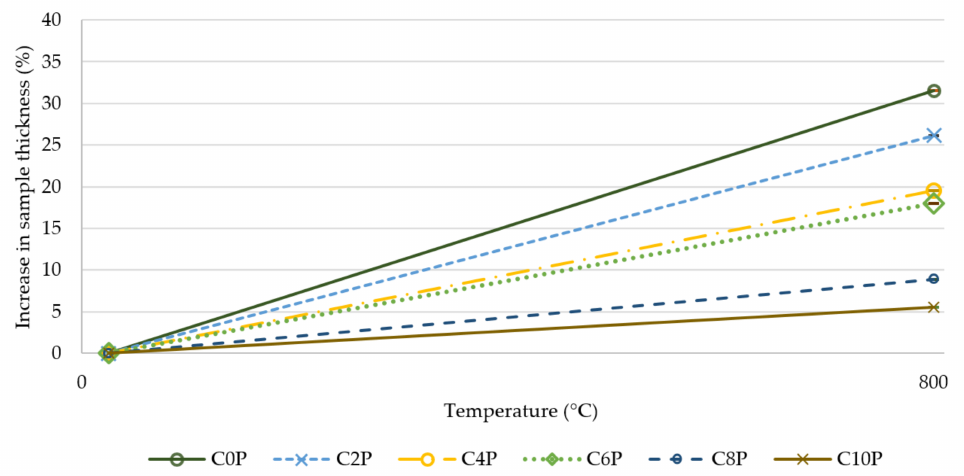
Figure 4. Increase in thickness (%) of composite samples after 800 ◦ C.